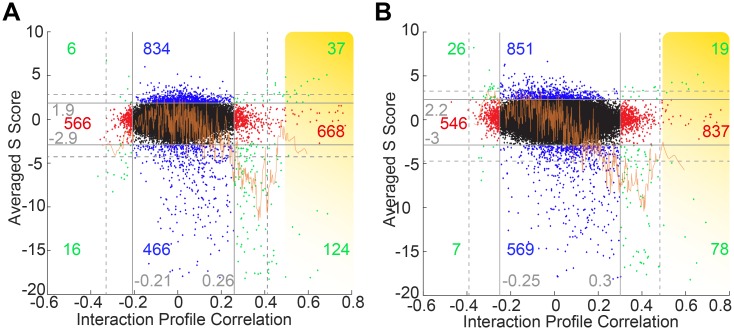
Profile of genetic interactions and correlations.(A, B) S scores and correlations for each of the 147’153 gene pairs of the MSP-E-MAP (A) and the MSP/C-E-MAP done on Cerulenin (B). Each of the 147’153 gene pairs is represented by a dot with its x- and y-coordinates corresponding to the S score and profile correlation, respectively. Horizontal and vertical gray lines separate statistically non-significant from significant values (unadjusted P values ≤ 0.005 for S scores and ≤ 0.05 for correlations, respectively). Significant S scores associated with non-significant correlations are in blue, significant correlations associated with non-significant S scores are in red and significant correlations associated with significant S scores are in green. The yellow zones in (A) and (B) together highlight 68 gene pairs with correlations > 0.5 listed in S2C Table. Dotted lines indicate significance thresholds (P<0.05) after Bonferroni corrections (S2B Table, S3 Text, Materials and Methods). The orange lines indicate the average of significant S scores as a function of the correlation coefficient obtained with a window of 10 values.